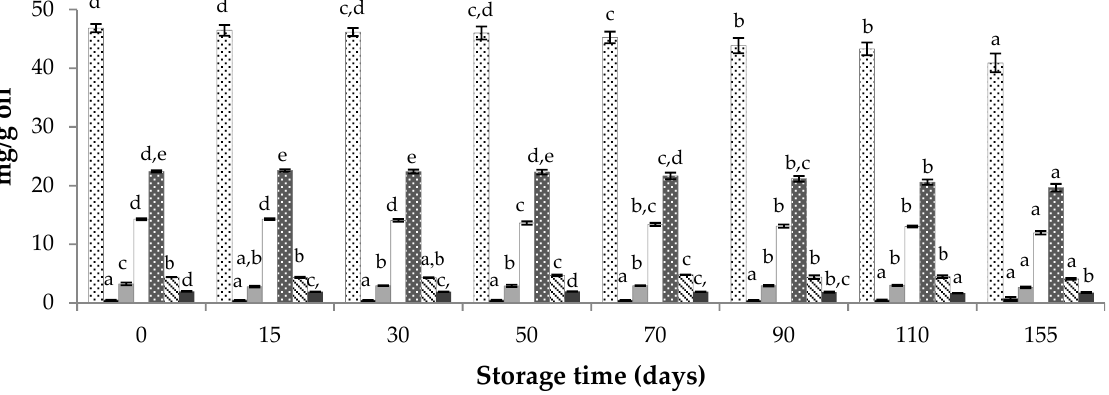
Figure 1. Variation of alkylresorcinol (AR) contents during storage at 21 ± 1 °C and darkness of the SCWBOE. Different letters within the same compound indicate significant mean differences according to LSD test at p < 0.05.